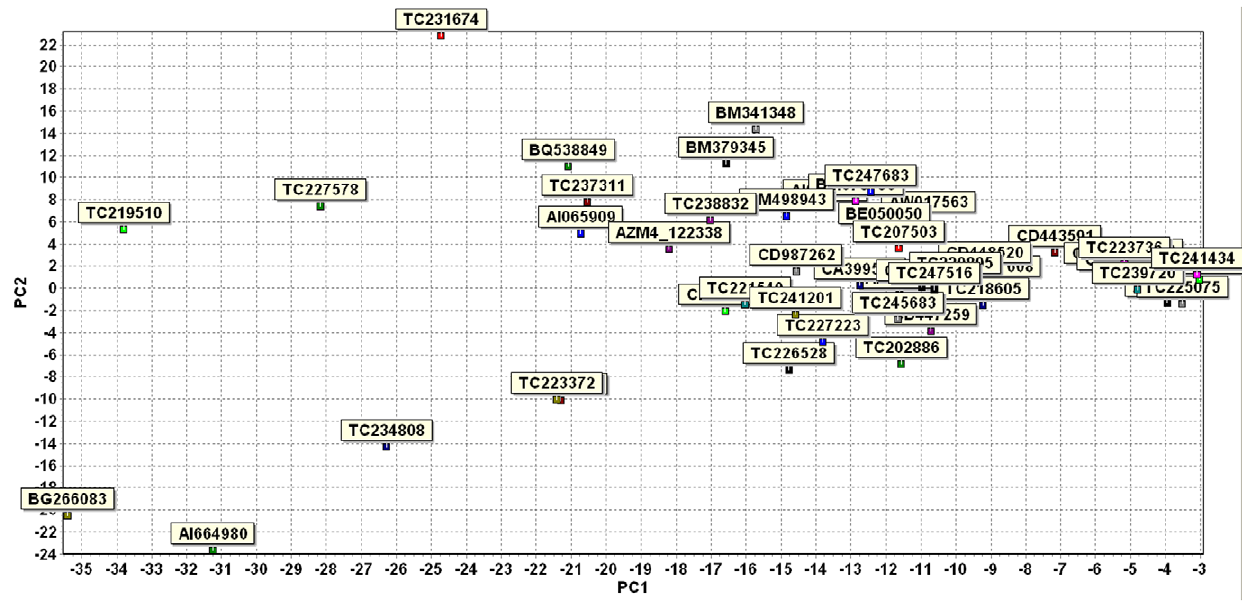
Figure 4. Plot of PCA analysis on the 50 candidate genes differentially expressed in Mp313E versus Va35. Genes highly expressed in Mp313E were presented in the area with positive values of y axis coordinates, whereas genes located in the area with negative values of y axis coordinates were those expressed more inVa35.